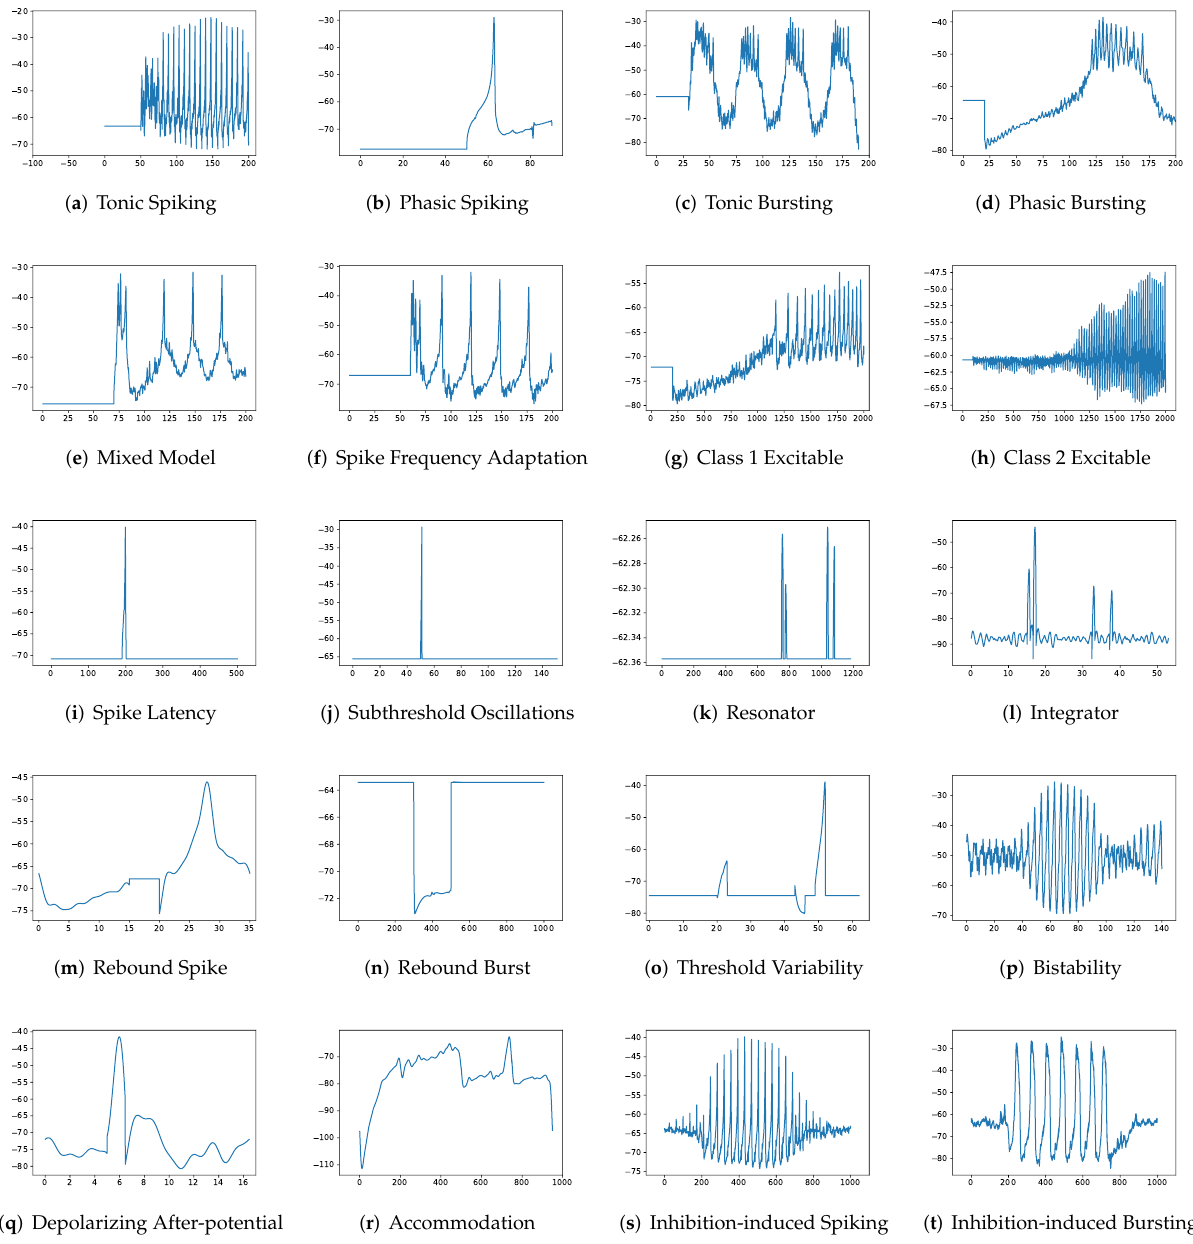
Figure 6. Membrane potentials of RSSRM, where y-axis is the membrane potential (mV) and x-axis is the time